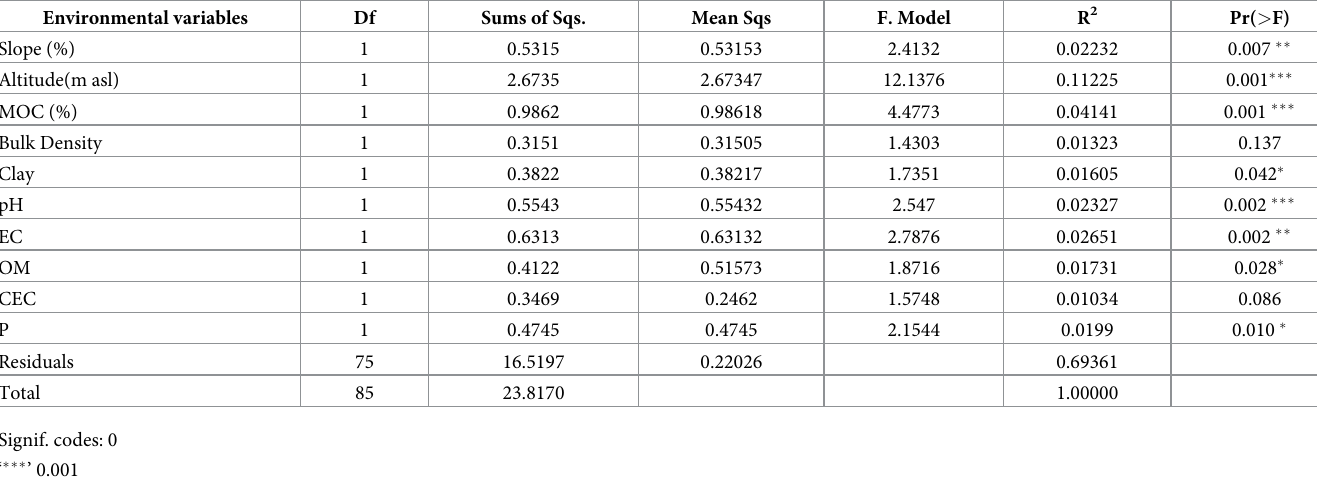
Table 7. Result of function donis test of environmental variables (significant environmental variables are indicated by Asterix at their p-value) the study area. Environmental variables Df Sums of